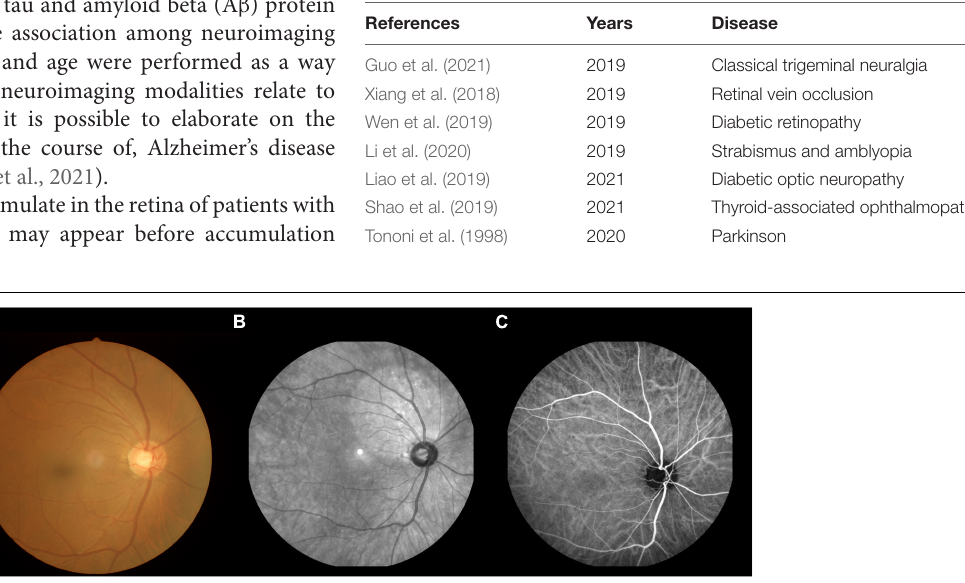
FIGURE 1 | An example of MCI. (A) Fundus photography; (B) fundus fluorescein angiography; (C) indocyanine green angiography. MCI, mild cognitive impairment.